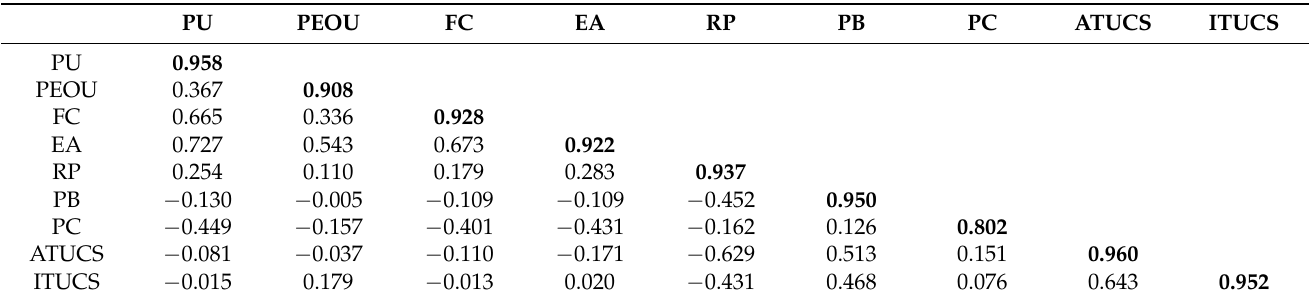
Table 5. Results for discriminant validity assessment of the